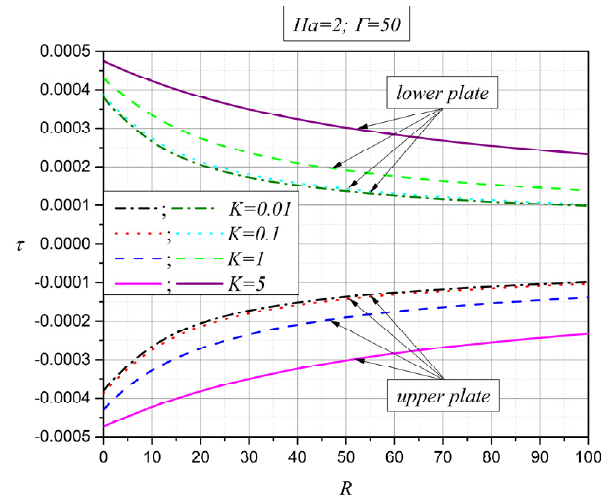
Figure 15. Shear stress on upper and lower plate for different values of porosity parameter R and coupling parameter K .